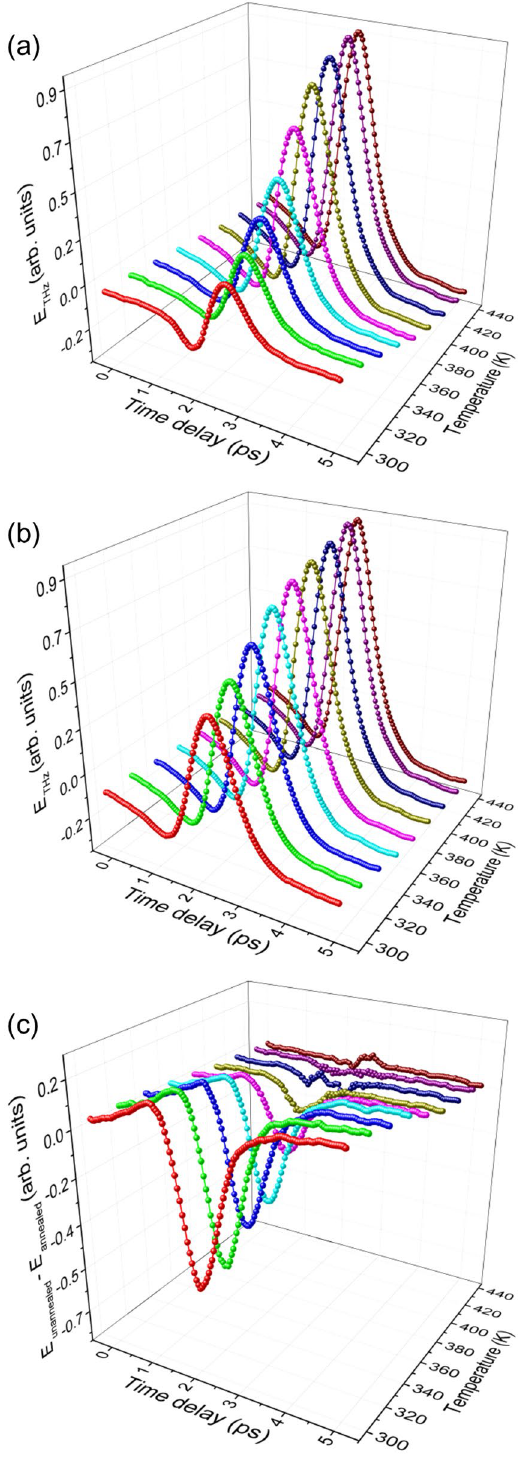
Figure 3. THz emission from CVD Graphene/InP at different temperatures in vacuum (1 × 10 − 2 Pa). ( a ) Pre- exposed in air, and ( b ) after annealing at 445 K for 1 hour in vacuum. ( c ) − ≅ E E E different temperatures for CVD